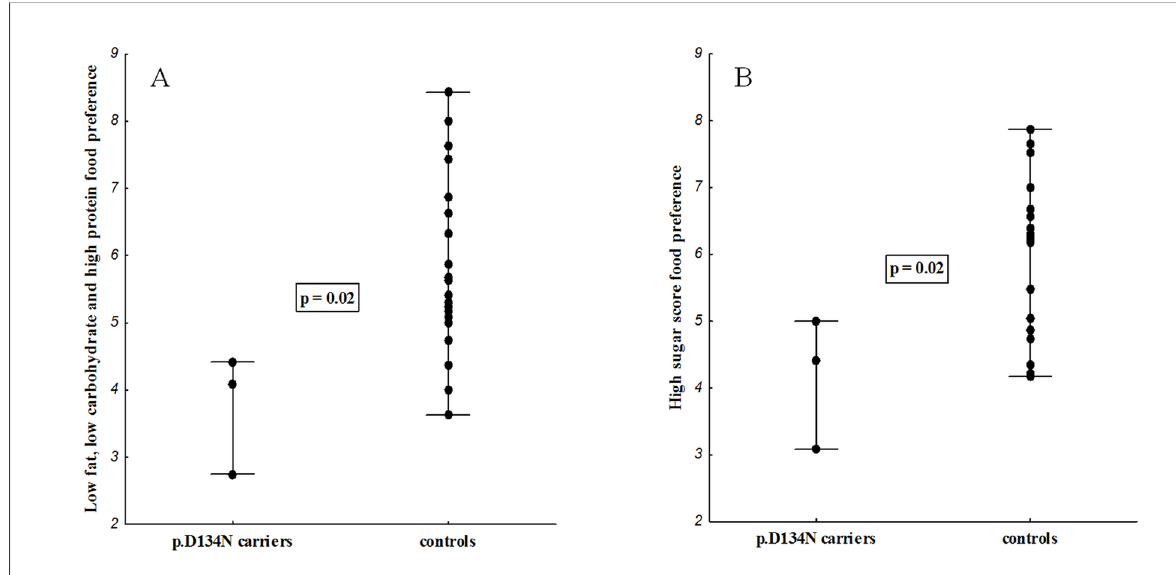
Fig 2. Food preference for the novel SIM1 variant p.D134N carriers(proband, her father and brother) compared to unrelated obese adult controls. A) Food preferencefor the low fat, low carbohydrate and high protein food and B) Food preference for the high sugar